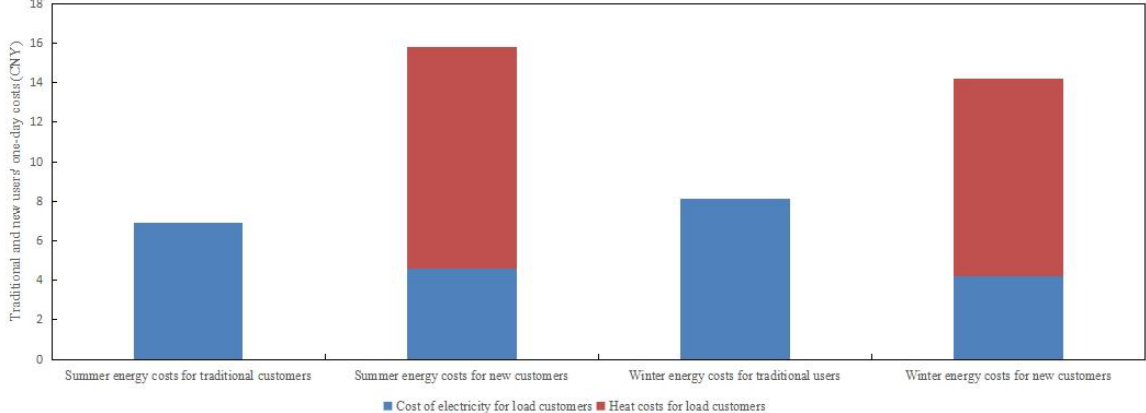
Figure 20. Comparison of typical daily energy cost between traditional users and new users in summer and winter.